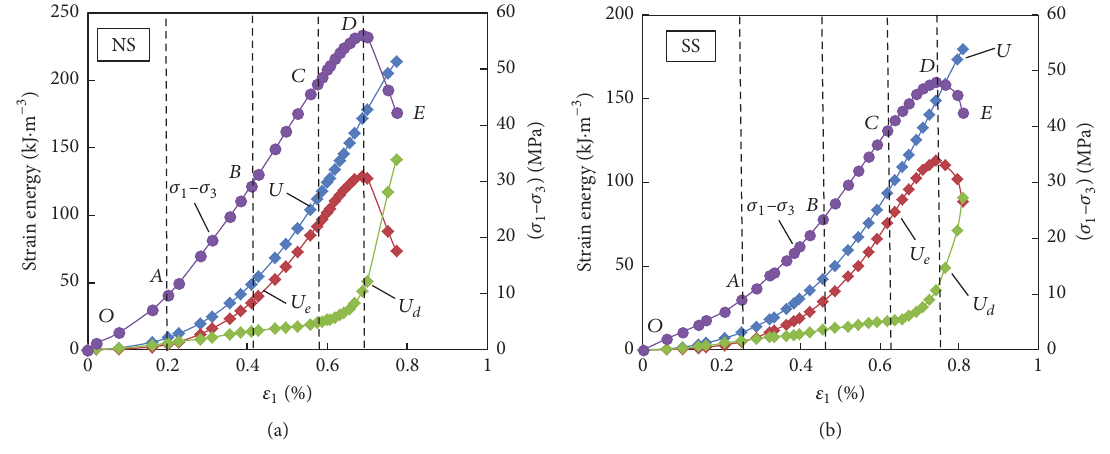
Figure 5: The energy conversion curves of uniaxial compression